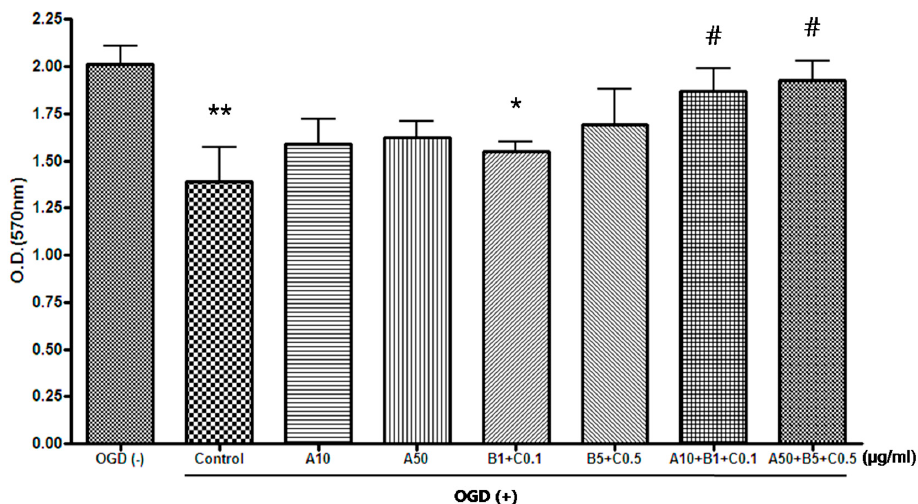
Figure 5. Effects of experimental drugs on MTT assay after OGD in SH-SY5Y cells ( µ g/mL, mean ± standard deviation, n = 5). OGD exposure significantly decreased the O.D. value of the cells. Compared with the control group, Sample A + B + C complex [both concentrations of A10 + B1 + C0.1 ( µ g/mL) and A50 + B5 + C0.5 ( µ g/mL)] significantly increased the O.D. value. Sample A and Sample B + C showed an increase in O.D. value compared to control, but there was no statistical